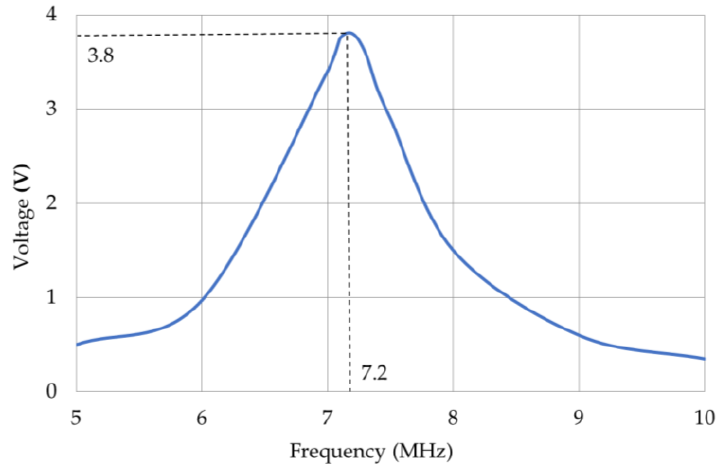
Table 2. Measured frequency shifts depending on the sensitive phthalocyanine layer ’s parameters.